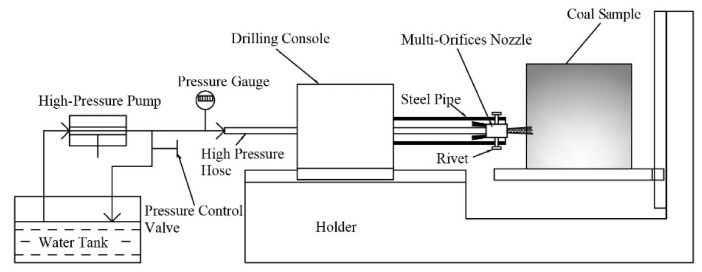
Figure 4. Device connection schematic for the self-drilling speed testing system.